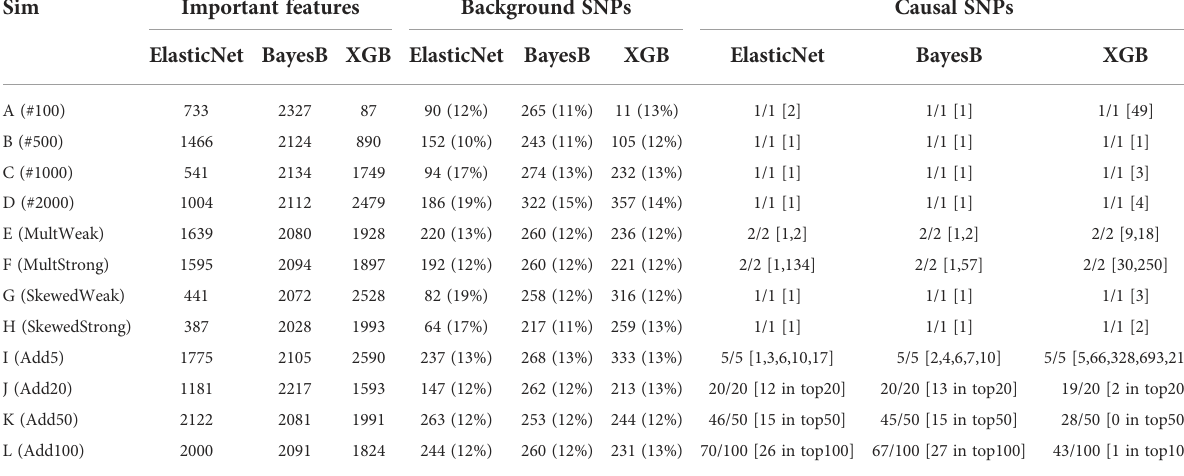
TABLE 2 Analysis of feature importances of Elastic Net, Bayes B, and XGB for synthetic data with h =0.95.